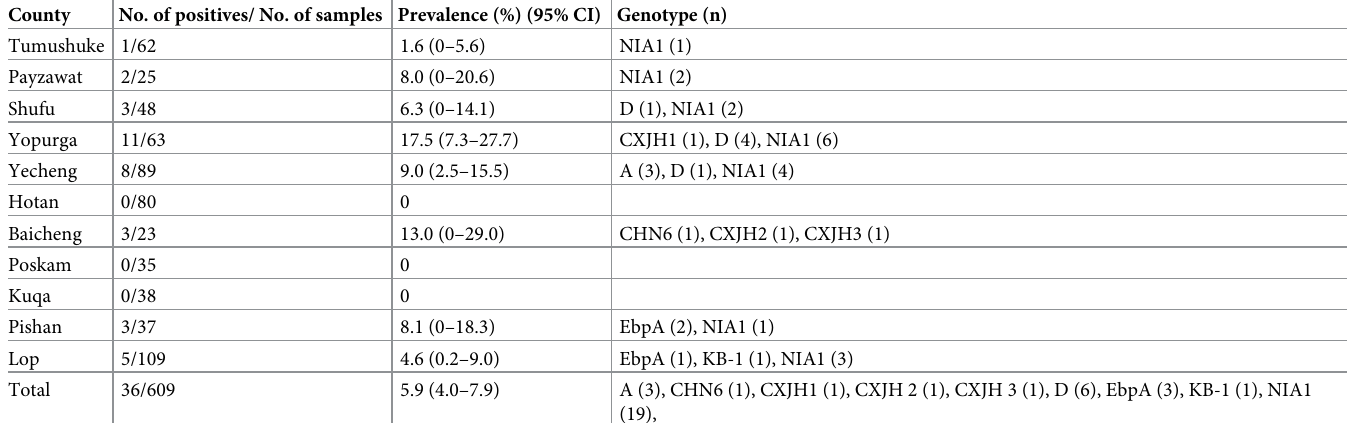
Table 1. Prevalence and genotype distribution of E . bieneusi among children in different counties of southern Xinjiang. County No. of positives/ No. of samples Prevalence (%) (95% CI) Genotype